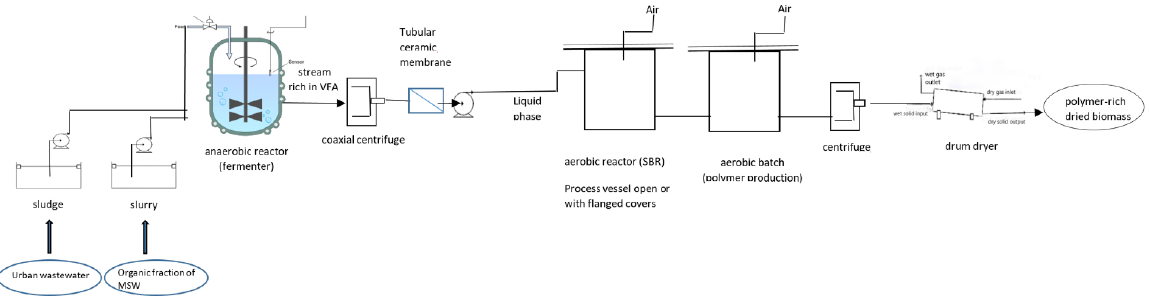
Figure 2. Process Flow Diagram (PFD) of integrated pilot plant platform for PHA production.